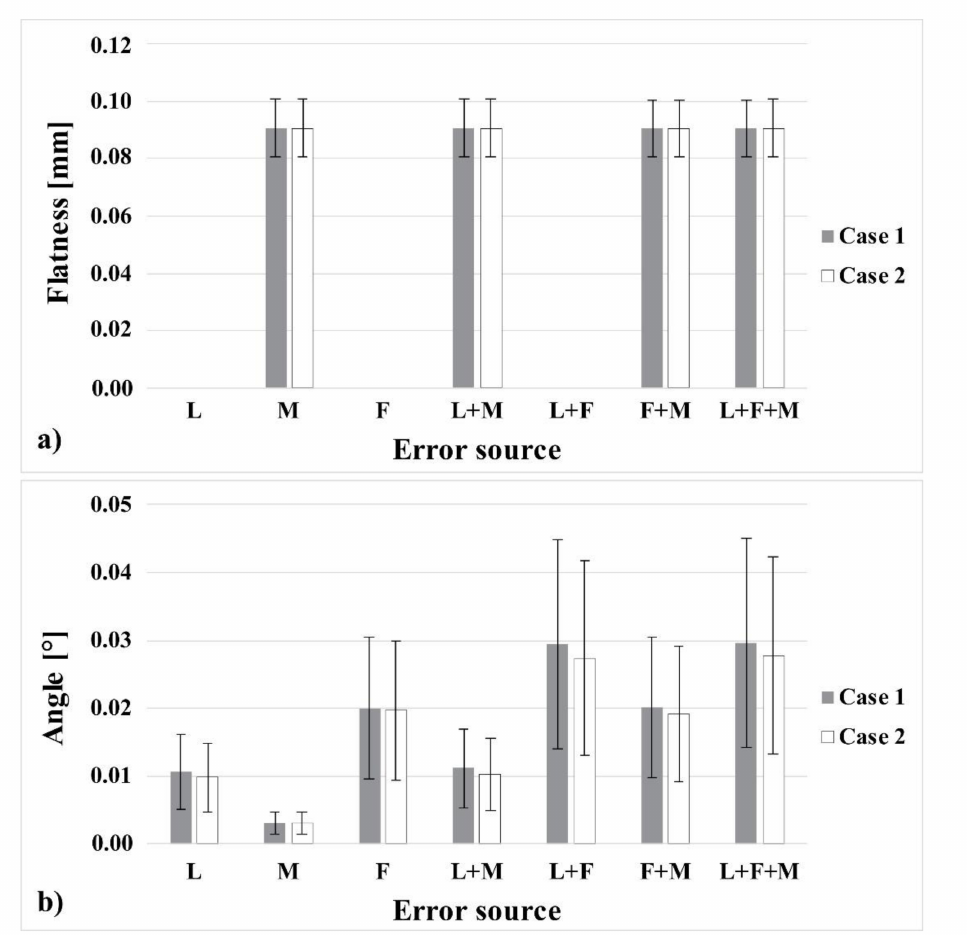
Figure 5. Results for the first (case 1) and second (case 2) configuration of the locators: ( a ) Flatness, ( b ) angle (L = locator uncertainty, M = volumetric uncertainty of machine tool, F = datum flatness, L + M = locator + volumetric uncertainty, L + F = locator + datum flatness, F + M = datum flatness + volumetric uncertainty, L + F + M = locator + volumetric uncertainty + datum